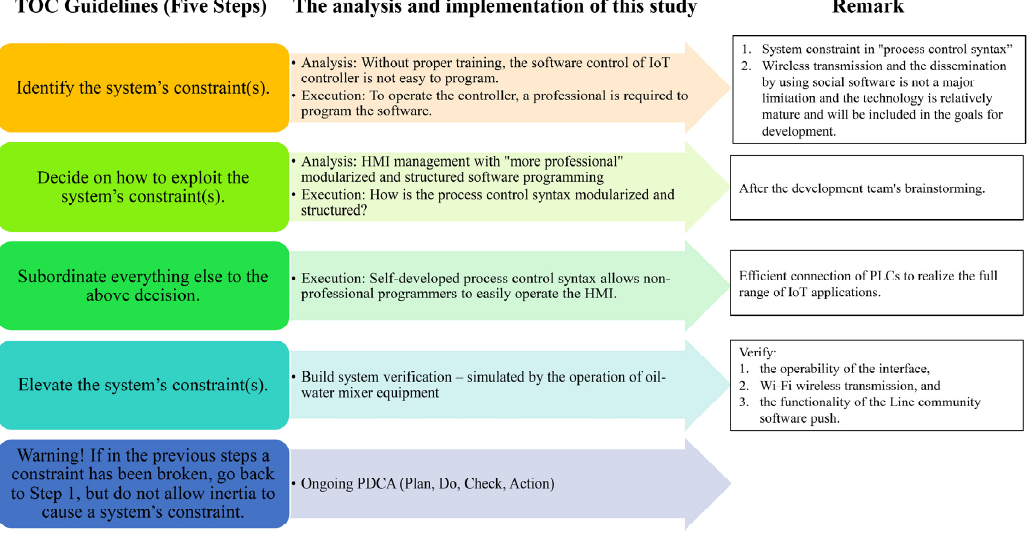
Figure 2. Analysis and implementation of the five phases of the TOC in this research.